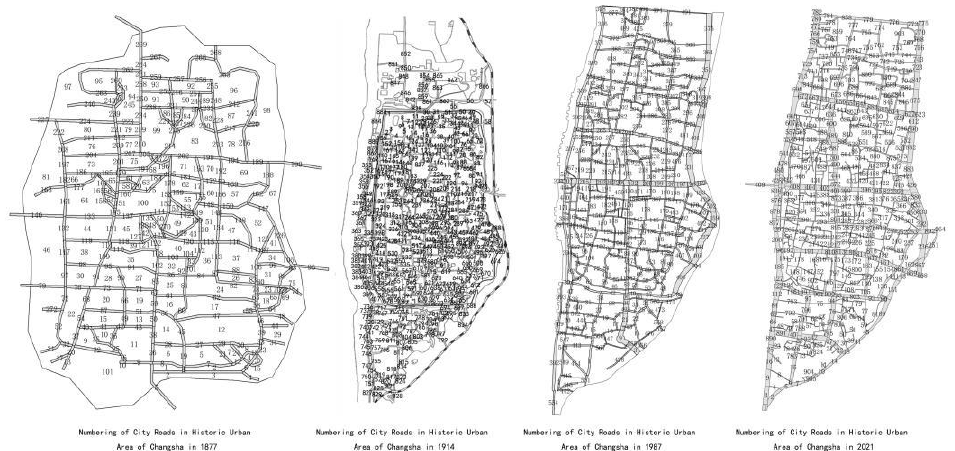
Figure 3. Network Numbering of City Roads in Various